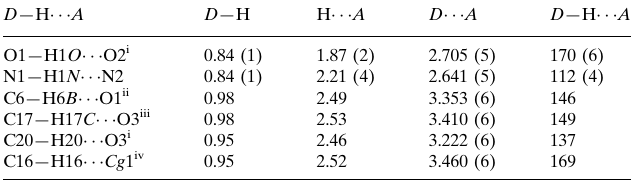
Hydrogen-bond geometry (A˚ , (cid:2) ). Cg 1 is the centroid of the C18–C23